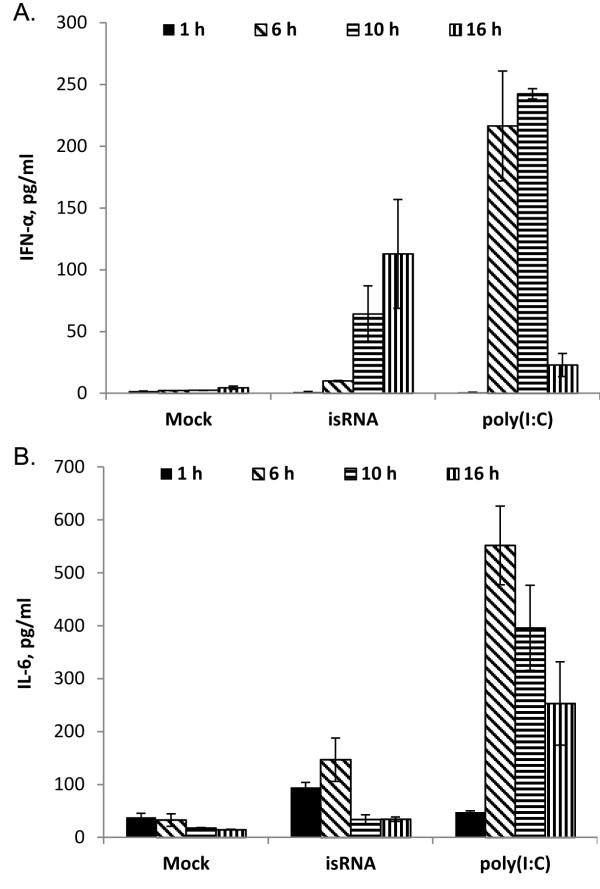
Stimulation of the innate immune response by isRNA and poly(I:C) in vivo. СBA/LacSto mice were intraperitoneally injected with isRNA (10 μg per mouse) or poly(I:C) (10 μg per mouse) in complex with Lipofectamine 2000. Serum IFN-a (A) and IL-6 (B) levels were measured by ELISA 6 h 1, 6, 10, and 16 hours after injection. Values for Lipofectamine-treated mice represent the Mock. The data represent means ± standard deviation (SD) calculated from measurements from at least three mice.